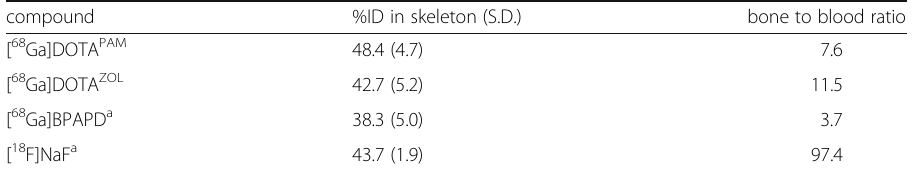
Table 2 Bone-to-blood ratios and calculated total activity in the skeleton in healthy Wistar rats, at